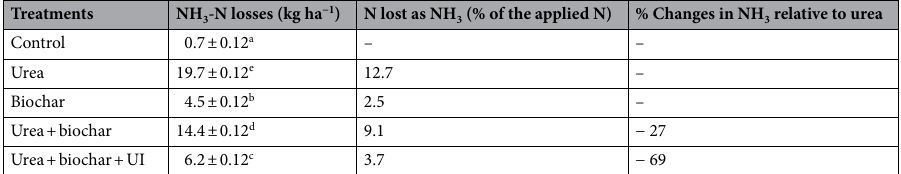
Table 1. Nitrogen losses as ammonia volatilization as affected by nitrogen application with and without biochar and/or urease inhibitor. Means followed by same letter(s) within columns are statistically non- significant (p <